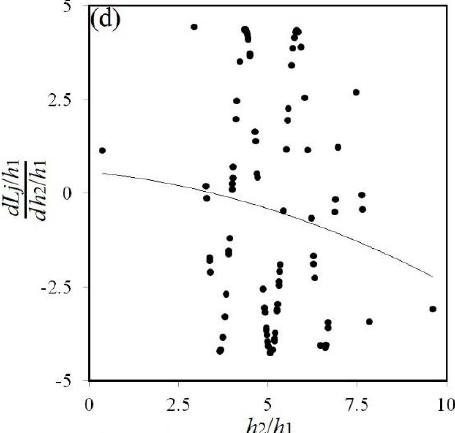
Figure 6. Results of sensitivity analysis for GEP 1 model (a) Froude number (b) bed slope (c) bed roughness (d) sequent depth